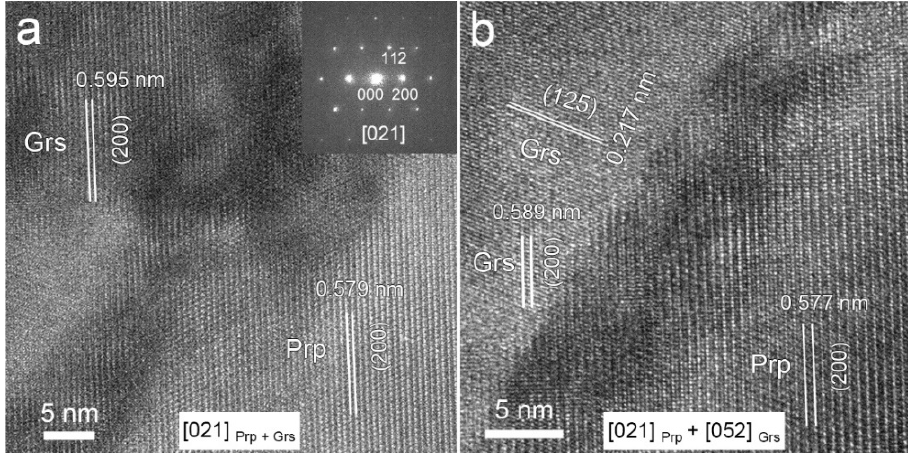
Figure 6. HRTEM images of Grs-rich exsolutions in Prp-rich host show they are bearing both ( a ) coherently and ( b ) incoherently crystallographic orientation with host. ( a )